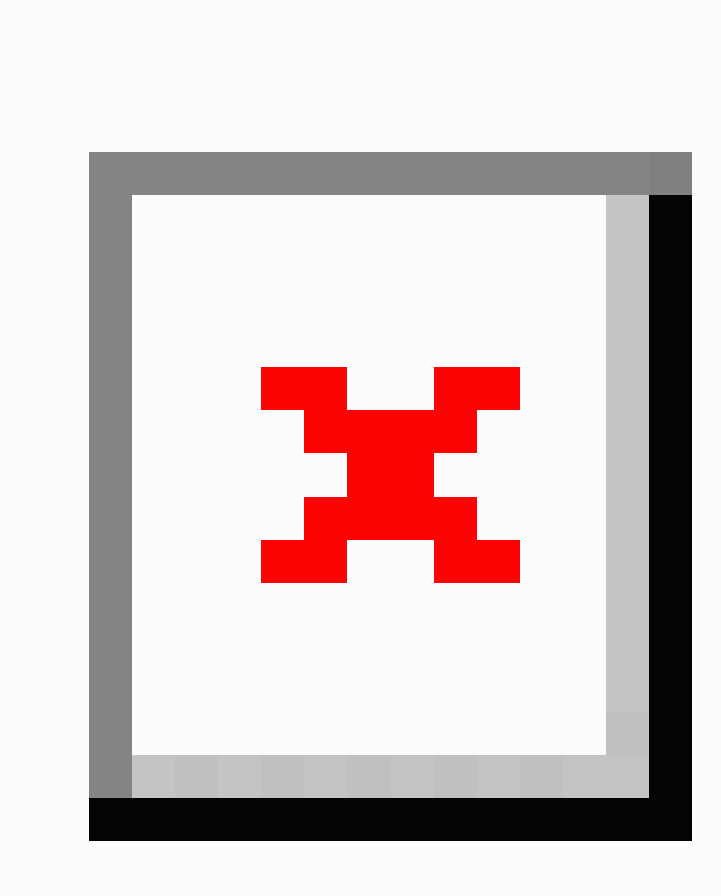
Figure 4. Histogram showing most common billing codes used. 99214 is an established patient office visit for 25 minutes (used with telemedicine code modifier); 99204 is a new patient office visit for 45 minutes (used with telemedicine code modifier); 99215 is an established patient office visit for 40 minutes (used with telemedicine code modifier); 99443 is a telephone evaluation and management for 21-30 minutes; 99442 is a telephone evaluation and management for 11-20